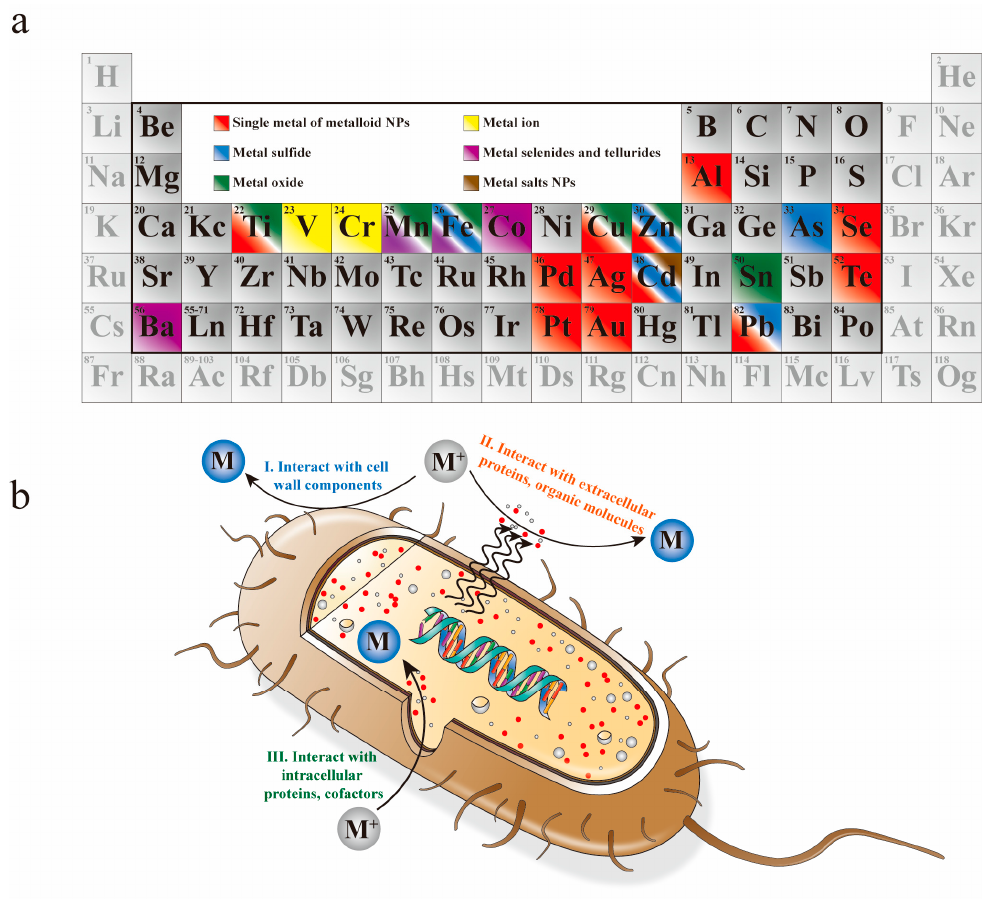
Figure 1. ( a ) Periodic table of elements that have been synthesized by bacteria. ( b ) Schematic representation of bacteria synthesis of NPs; both intracellular and extracellular process are included.